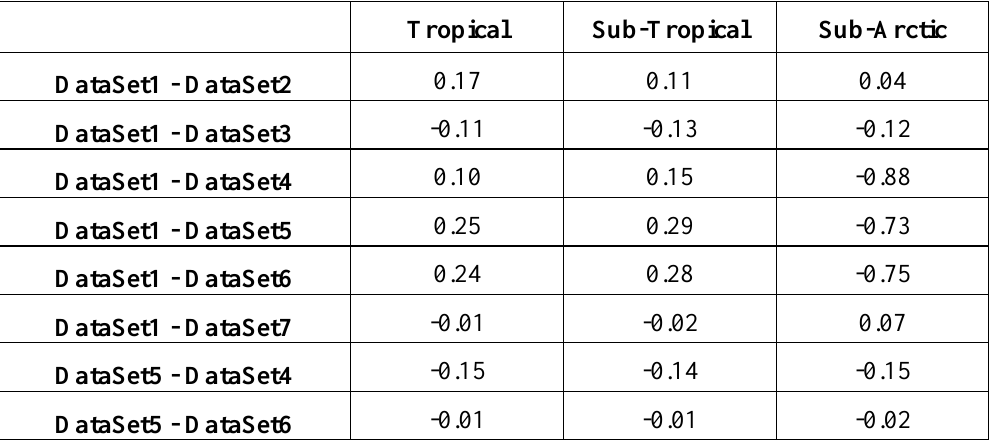
Table 5. Linear trends differences (mm/yr) between various datasets (obtained by OLS fit to the time series of the interannual SLA